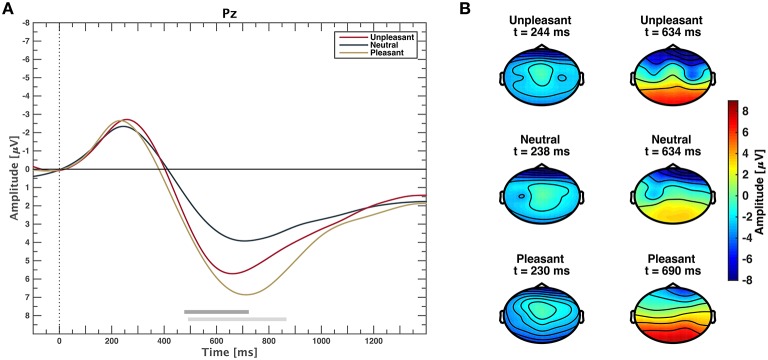
(A) Event-related potentials averaged over all participants for unpleasant, neutral, and pleasant stimuli on midline electrode Pz. Gray horizontal bars depict significant differences between neutral and pleasant (light gray) or neutral and unpleasant responses (dark gray), (p < 0.05, FDR corrected Wilcoxon test). Differences between unpleasant and pleasant conditions are not significant (p > 0.05, FDR corrected Wilcoxon test). (B) Scalp plots showing the topographic distribution where grand average responses are minimal (left) and maximal (right) at electrode Pz for unpleasant, neutral, and pleasant stimuli.